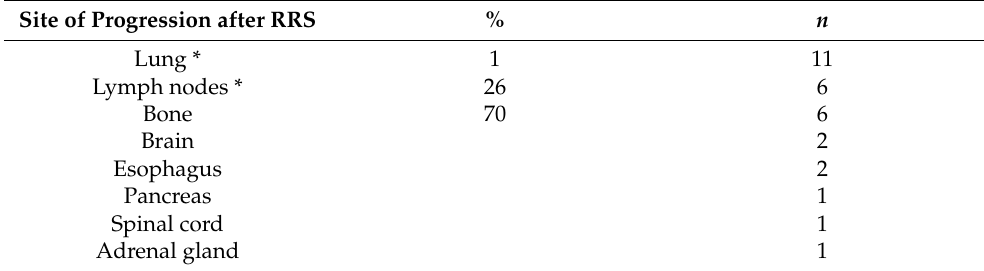
Figure 1. Progression-free survival and local progression-free survival after RRS. ( A ): Progression-free survival was calculated by Kaplan–Meier method. ( B ) Local progression-free survival was defined as recurrence within the area of the previous RRS. RRS: robotic radiosurgery, mo: months. Table 3. Site of progression after